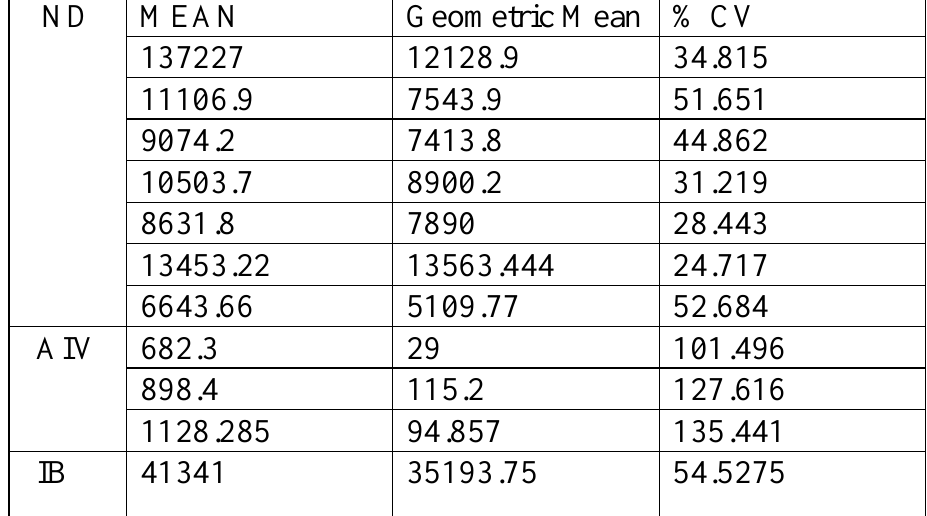
Table (1): ELISA results of ND, AIV and IB antibody titres from 1 st September to the end of